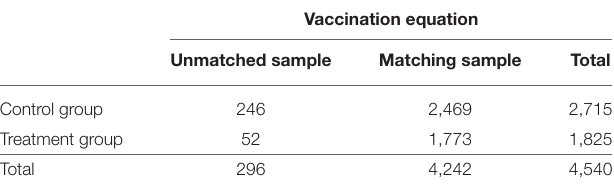
TABLE 3 | Result of sample